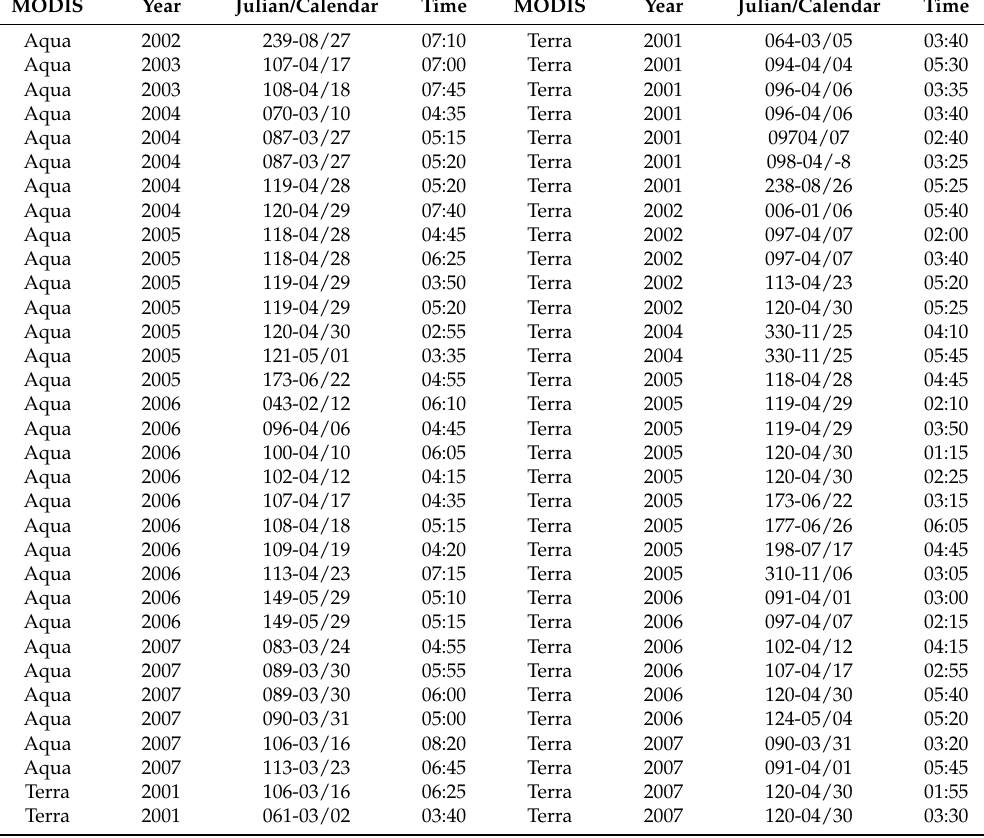
Table 3. Cloud events selected as training data for spectral and statistical